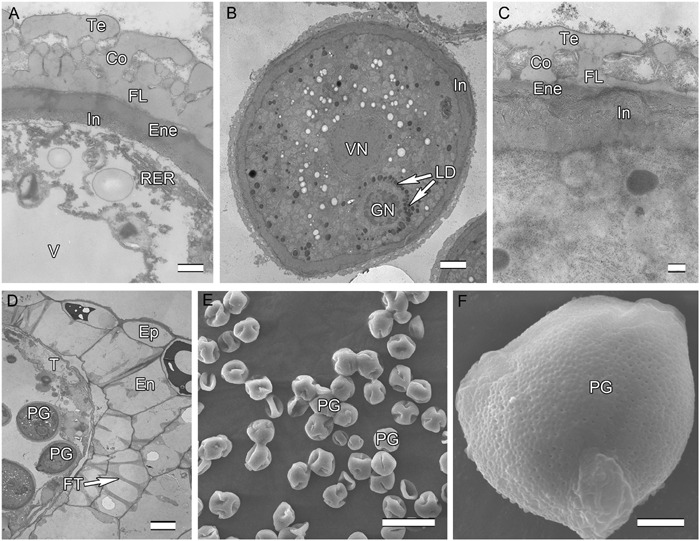
Ultra-thin sections of H. patens anthers. (A) Uninucleate microspore stage, showing the early-formed intine and associated RER. (B) Bicellular pollen stage, showing the GN surrounded by LD. (C) Bicellular pollen stage, showing the thickened and more electron-dense intine. (D) Bicellular pollen stage, showing cell layers of the anther wall, fibrous thickenings in the endothecium, and remnants of the tapetum. (E) MPGs released from the anther locule. (F) One PG, showing the micro-reticulate ornamentation and PO. Scale bars in (A) represents 500 nm; (B) represents 2 μm; (C) represents 200 nm; (D) represents 10 μm; (E) represents 50 μm; (F) represents 5 μm.